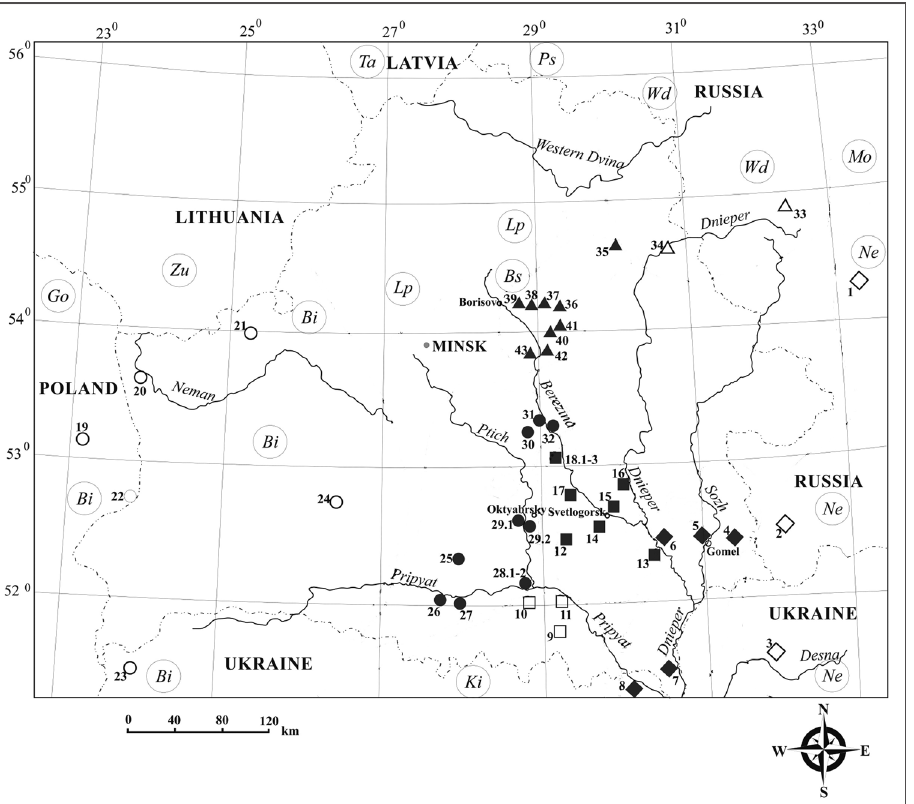
Figure 1. The distribution of the chromosome races of the common shrew in Belarus and neighbouring territories: Ne, Neroosa (diamonds); Ki, Kiev (squares); Bi, Białowieża (circles); Wd, West Dvina (light triangles); Bs, Borisov (black triangles); Go, Goldap; Zu, Zuvintas; Ta, Tallin; Ps, Pskov; Lp, Lepel; Mo, Moscow. See Suppl. material 1 for numbers of the collection sites. Dotted line indicates state